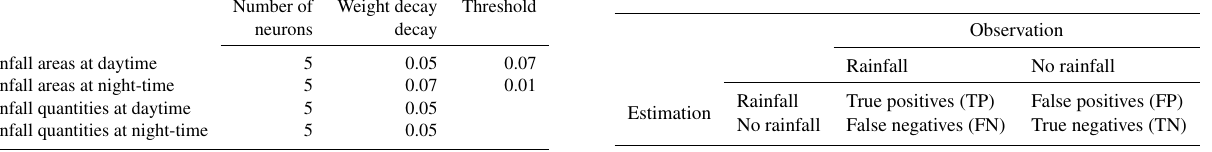
Table 2. Confusion matrix as a baseline for the calculation of the verification scores used for the validation of the rainfall area esti-